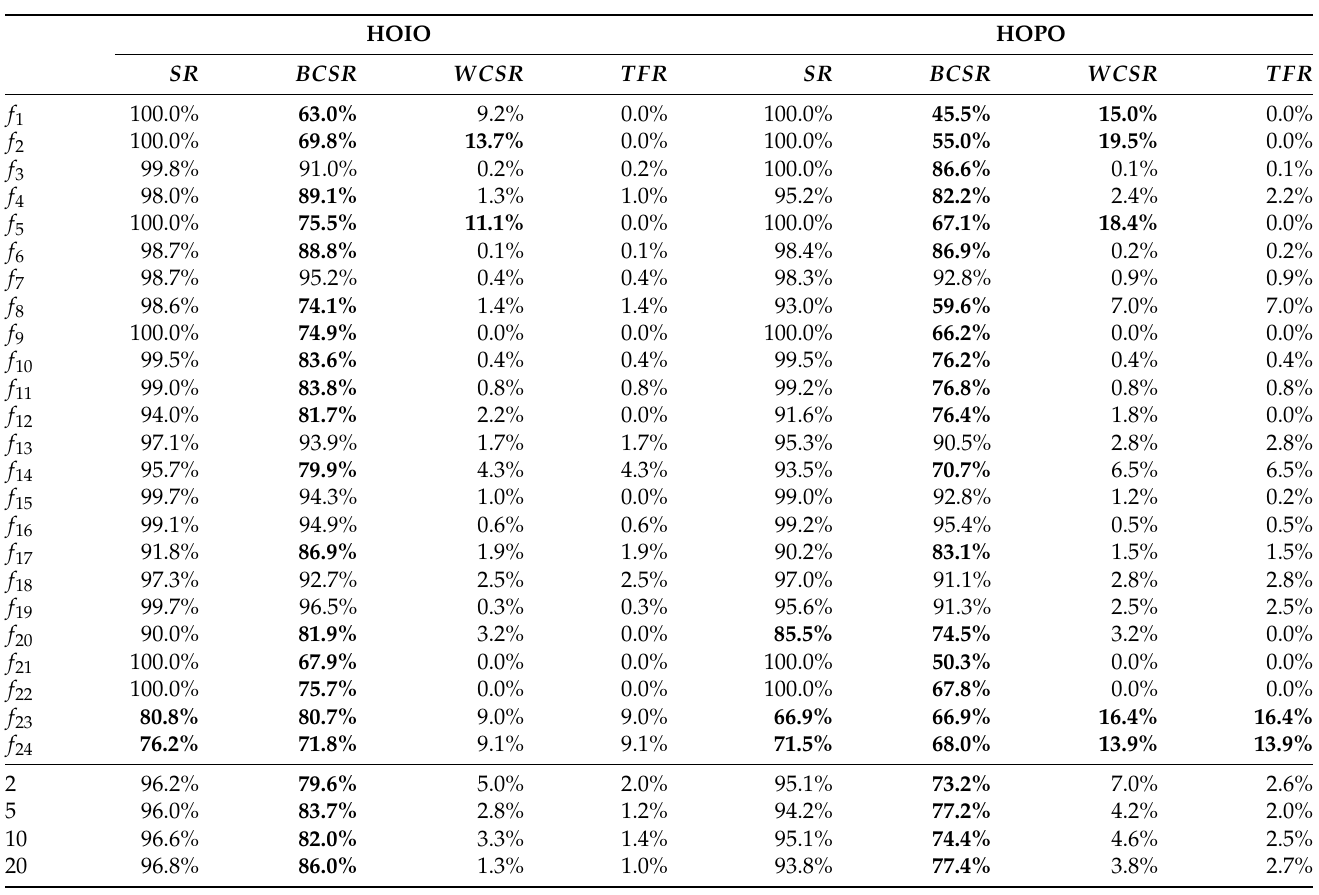
Table 4. Average SR across all for a given problem at a given dimension during HOIO and HOPO validations, and average BCSR and WCSR for a given problem at a given dimension during HOPO validations. In boldface are the SR and BCSR less than 90%, and the WCSR higher than